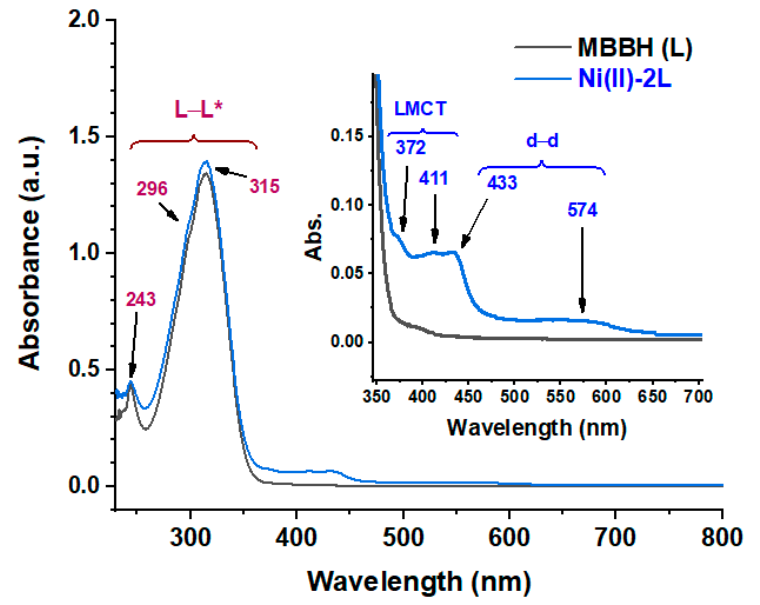
Figure 4. Mass spectrum (ES+ mode) of N ′ -(4-methoxybenzylidene)benzohydrazide (HL) Schiff base and its suggested fragmentation pathways.